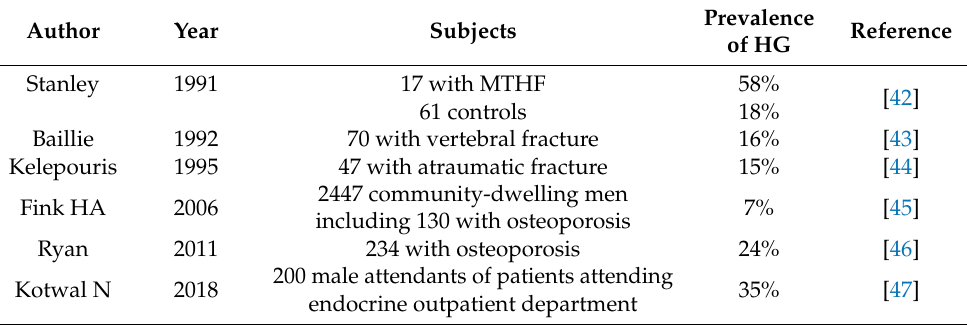
Table 1. Prevalence of hypogonadism in men with osteopenia or bone